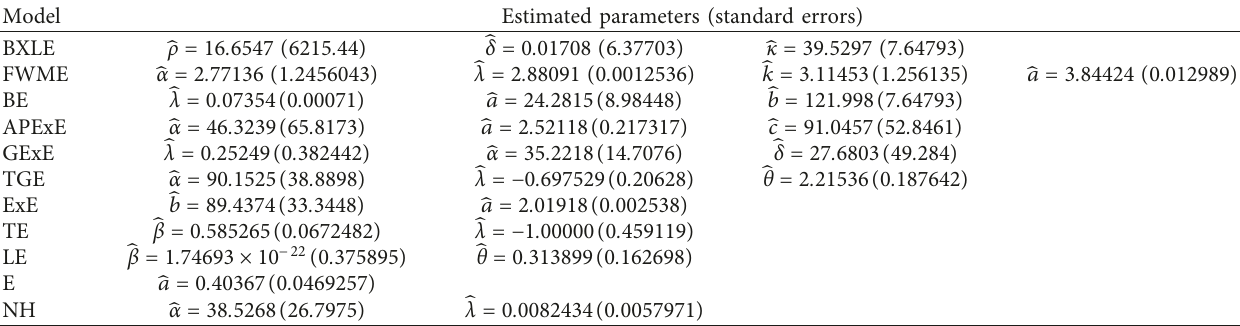
Table 9: Estimated parameters with their standard errors of the BXLE model and other fitted models for first dataset.